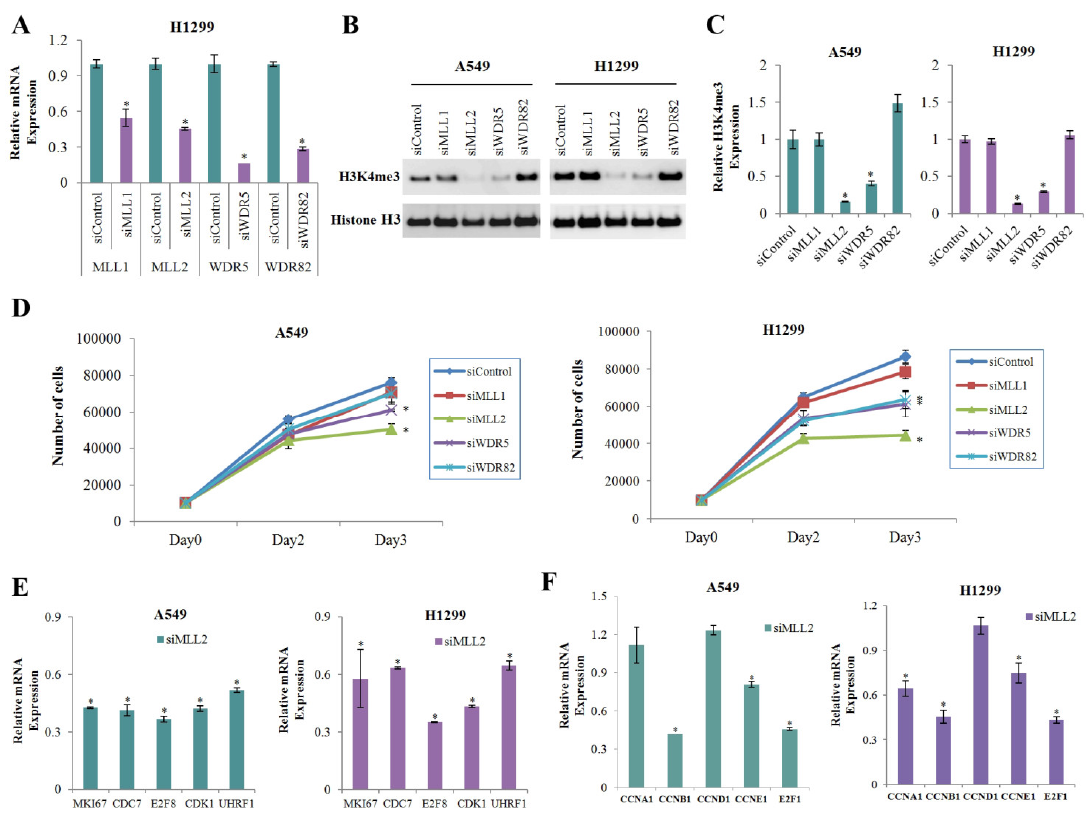
Figure 4. Effects of MLL2 on H3K4me3 and the mRNA levels of positive regulators of cell cycle. A549 and H1299 cells were transfected with siMLL1, siMLL2, siWDR5, siWDR82, and the off-target control siRNA (siControl). ( A ) The relative mRNA levels of the targeted genes were measured by qRT-PCR ( n = 3, * p < 0.05). ( B ) The expression level of H3K4me3 was analyzed by western blotting. The uncropped blots of ( B ) were shown in Figure S4. ( C ) Levels of H3K4me3 in the siRNAs relative to the siControl. The western blot analysis was performed three times, and the average value was calculated. Error bars indicate the standard deviation ( n = 3, * p < 0.05). ( D ) Cells were transfected with the indicated siRNAs, and the number of cells was calculated using the WST-8 assay on the zero, second, and third days after transfection ( n = 4, * p < 0.05). ( E , F ) The mRNA levels of positive regulatory genes of cell cycle whose H3K4me3 levels were reduced significantly ( E ) or were not changed ( F ) in response to metformin were measured by qRT-PCR. Values are expressed as fold changes from siMLL2 to siControl ( n = 3, * p < 0.05). The error bars in all bar graphs indicate the standard deviation ( n = 3, * p < 0.05).